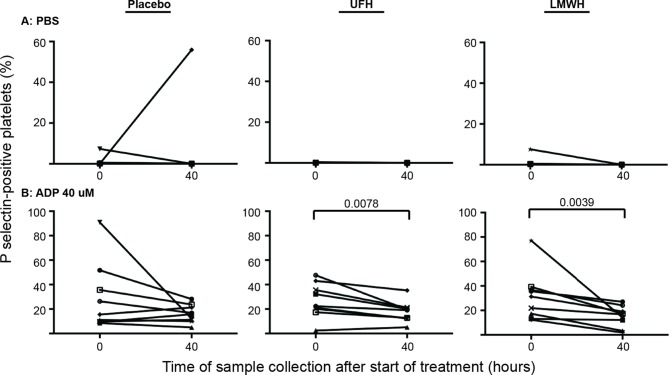
 Changes in the percentage of platelets expressing P selectin in platelet-rich plasma of 9 individual horses at 0 h (baseline) and 40 h after starting treatment (4 h after the last dose) with placebo (left column), unfractionated heparin (UFH, middle column) or low-molecular-weight heparin (LMWH, right column). Platelets were exposed to the PBS negative control (A) or the ADP positive control (B), 40 µM) for 10 min ex vivo. Significant changes in the median percentage of platelets expressing P selectin at 40 h compared to baseline (0 h) are shown. Each horse has the same unique symbol at both time points for all treatments (horse 1: -□-; horse 2: -○-; horse 3: -⋆-; horse 4: -⧫-; horse 5: -X-; horse 6: -▾-; horse 7: -·-; horse 8: -▪-; horse 9: -▴-). Note the Y-axis scale for PBS differs from that of ADP.